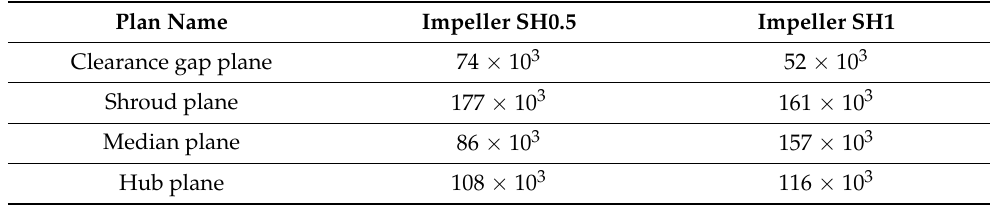
Figure 14. Vorticity magnitude in the fl uid volume for the two pumps with impeller SH0.5 and SH1 Table 2. Maximum vorticity at four planes of two Table 2. Maximum vorticity at four planes of two prototypes.